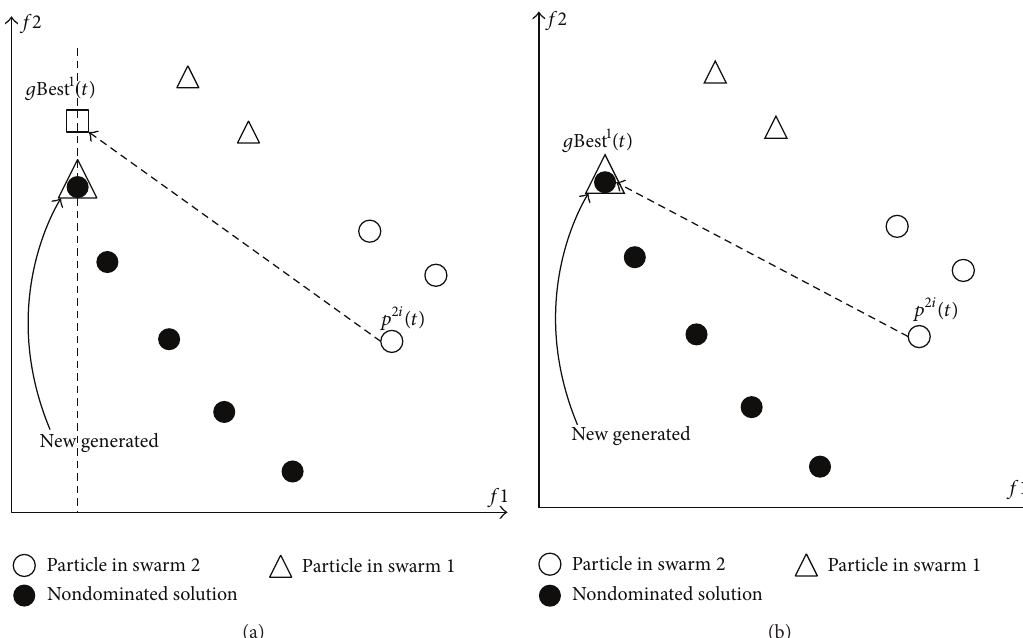
Figure 3: (a) Particles guided by the best solution from the other swarm (b) Particles guided by a nondominated solution with respect to another swarm.